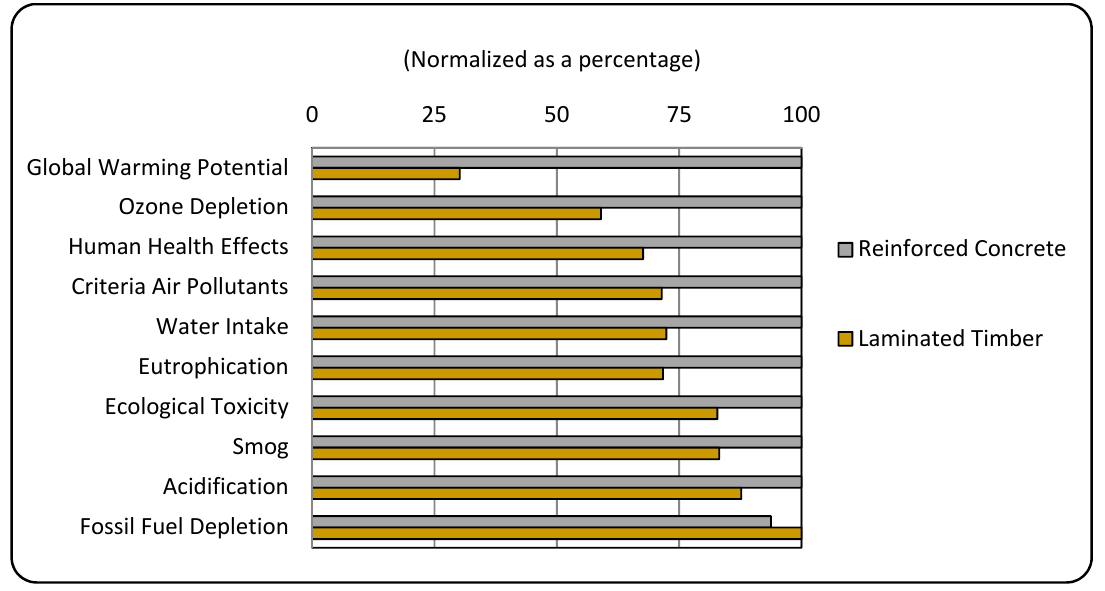
Figure 2. Environmental impact comparison of the concrete and timber design